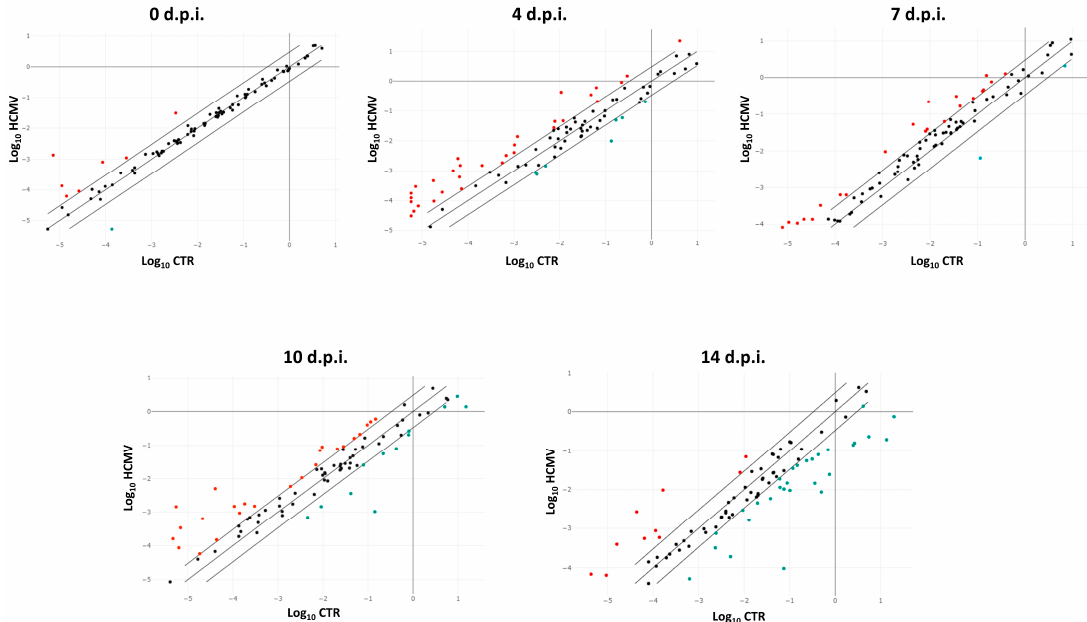
Figure 1. Scatterplot representation of the fibrosis-associated factors altered by human cytomegalovirus (HCMV) infection in primary human dermal fibroblasts. At each time p.i. (d.p.i. = days post-infection), cell samples were collected and analyzed by specific qPCR microarray. The significance threshold was put at 3-fold expression change in infected vs. uninfected control cells. Red dots: upregulated factors; blue dots: downregulated factors; black dots: not significantly altered factors. Results represent mean values of duplicate samples from two independent experiments, and are expressed in a logarithmic scale (Log 10 HCMV = logarithmic values in HCMV infected cells; Log 10 CTR = logarithmic values in control uninfected